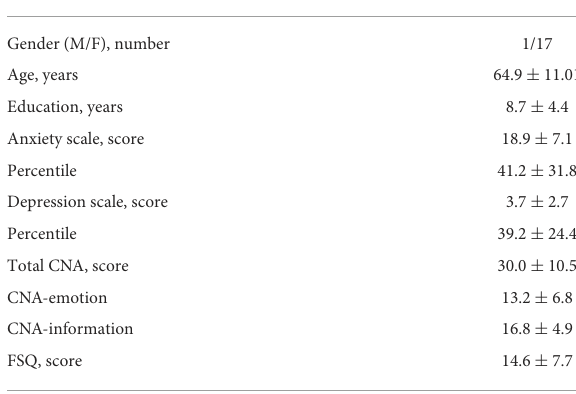
TABLE 2 Clinical characteristics and evaluations in caregivers at admission (T0) to the telepsychology service. Caregivers at T0 ( n =